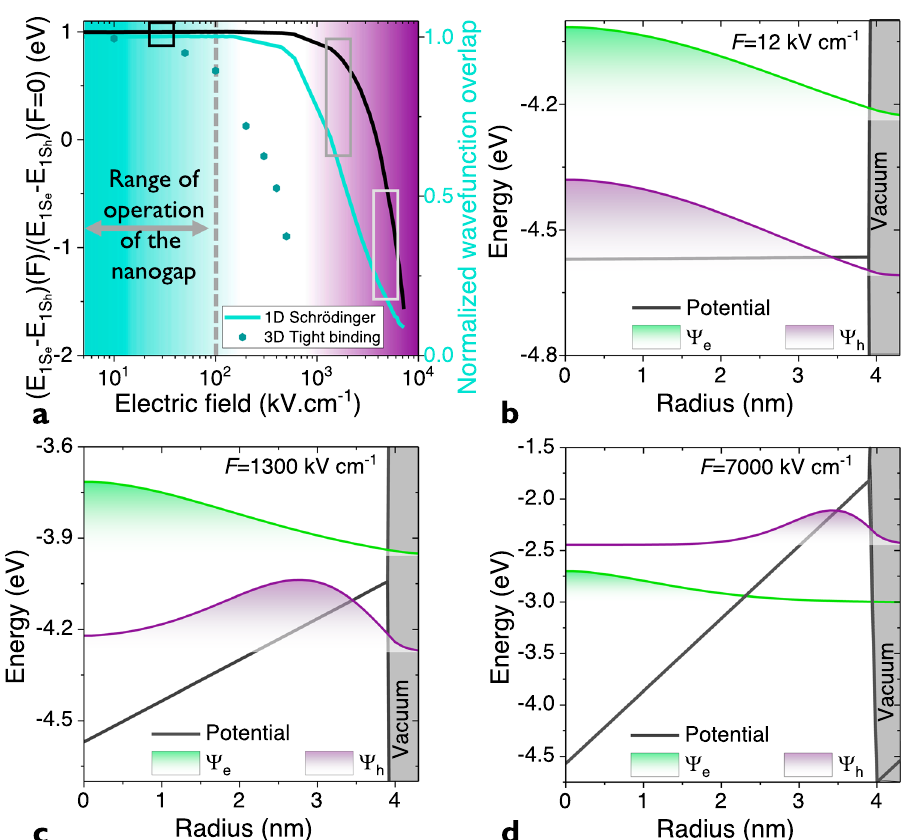
Fig. 4 Effect of the electric fi eld on spectra and wavefunction overlaps. a Relative change of the band-edge energy (black) and electron-hole overlap (blue) as a function of the applied electric fi eld. b (resp c , d ) Energy pro fi le (black) as a well as electron ( ψ e , blue) and hole ( ψ h , red) wavefunctions under an electric fi eld ( F ) of 12 kV cm − 1 , (resp 1300 kV cm − 1 and 7000 kV cm − 1 ). The vacuum energy is set to 0 eV. The wavefunctions are shifted to their eigen